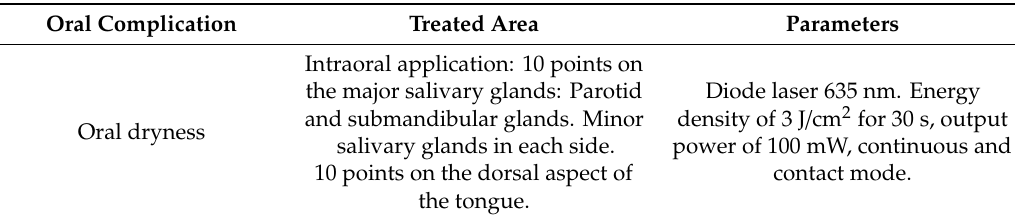
Figure 2. PBM treatment area for the management of oral dryness [19] Photobiomodulation therapy for the management of oral dryness: Parameters and treatment protocol.